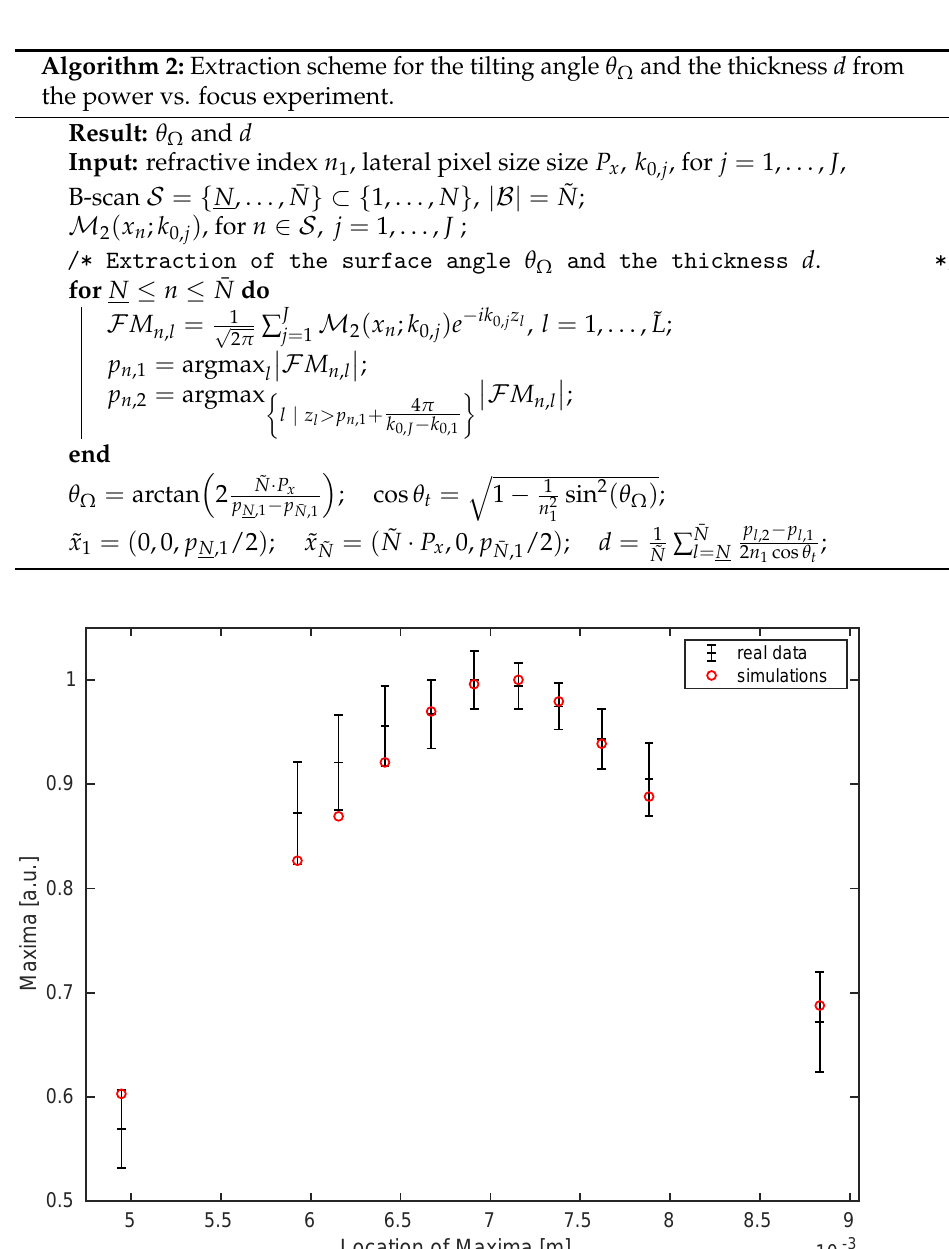
Figure 5. Comparison of averaged maximum values for all B-scans (of different sample locations) of the experimental data (black with errorbars) and the simulated data points (red) for the mirror